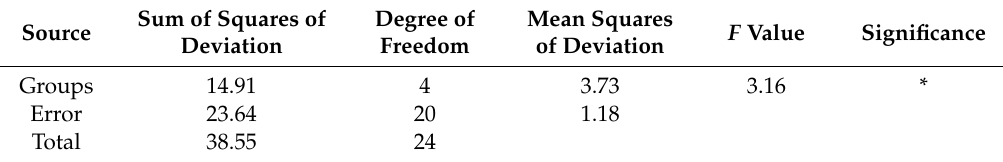
Table 6. Variance analysis result of absolute